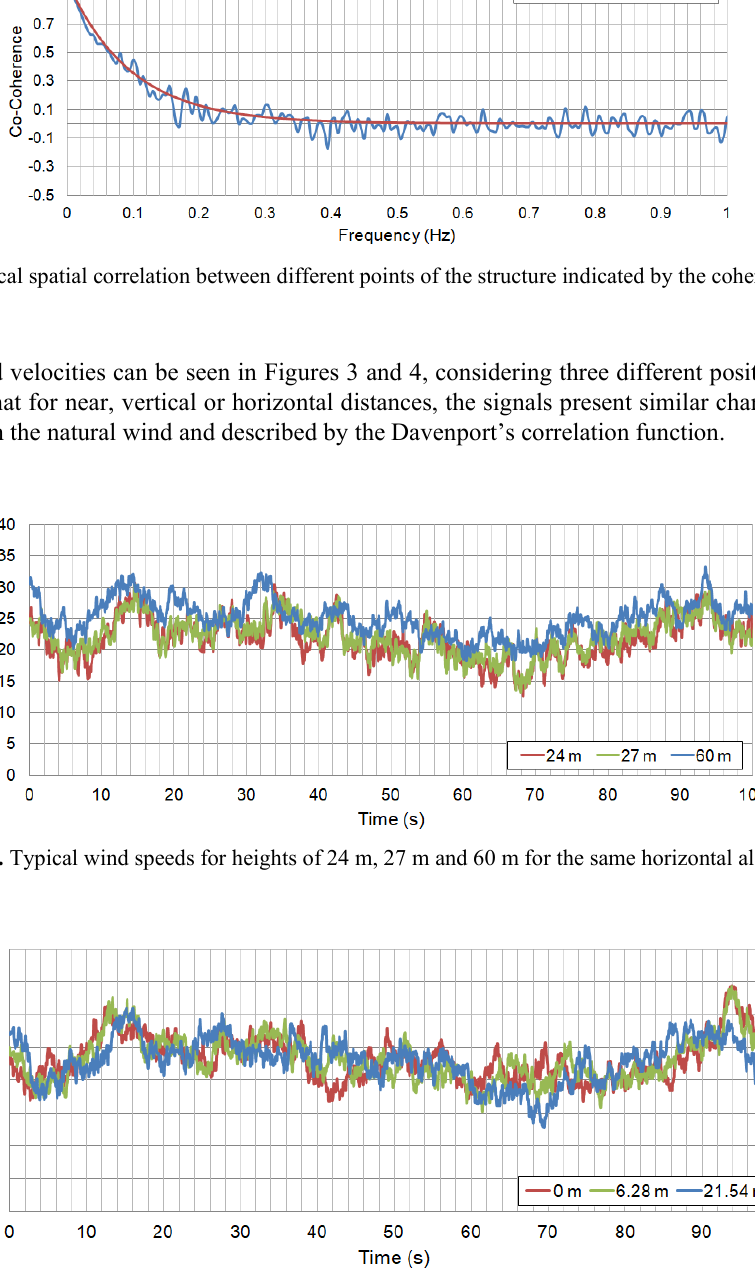
Figure 4. Typical wind speeds for horizontal position of 0, 6.28m and 21.54 m for the same vertical alignment of the